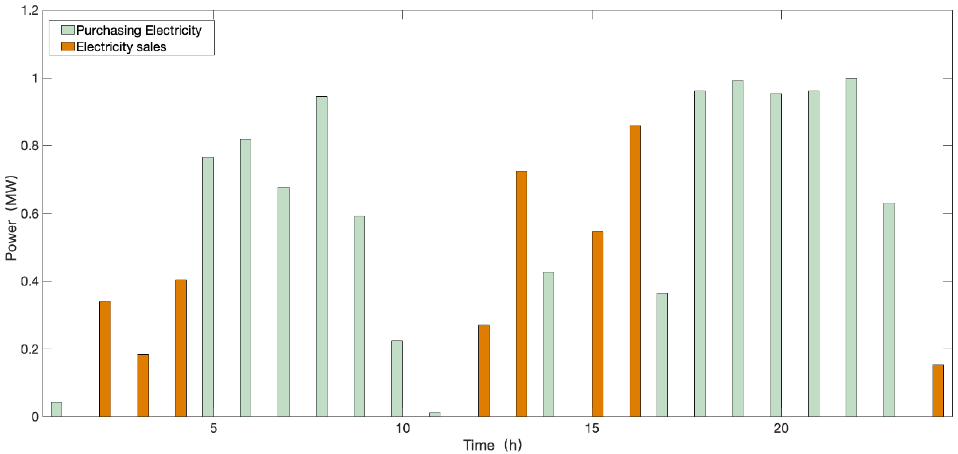
Figure 9. Opportunity strategy for DERA in the day-ahead market.